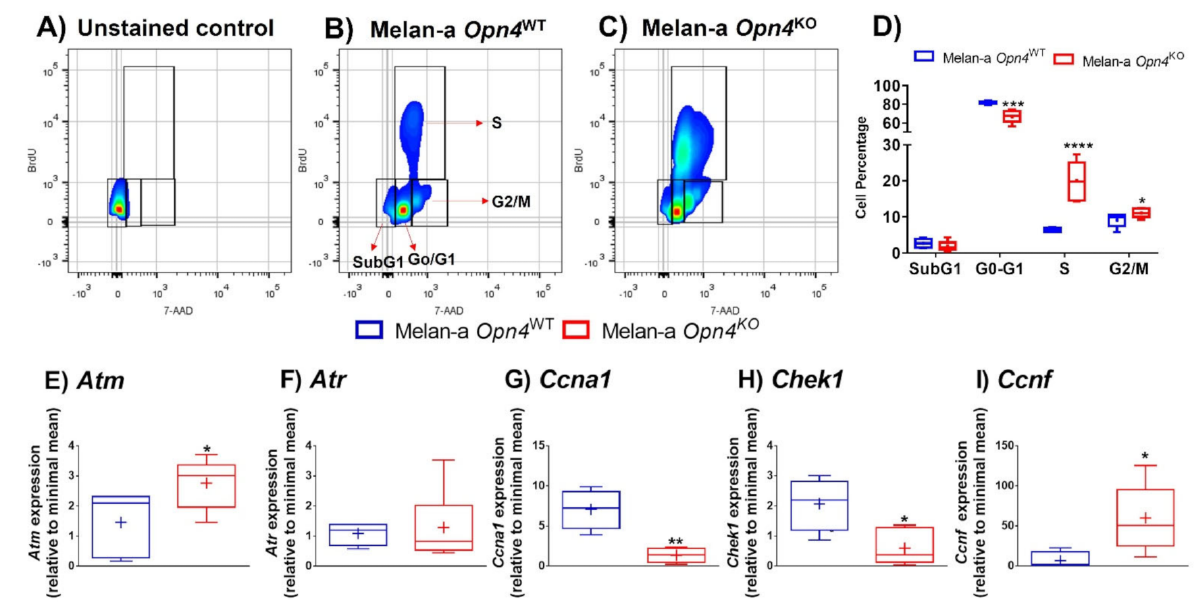
Figure 2. Cell cycle evaluation by 7-AAD and BrdU staining and by the expression of cell cycle-related genes in Opn4 WT and Opn4 KO melanocytes. ( A – C ) Representative gate of 7-AAD and BrdU stained cells; ( D ) quantitative analysis of cell cycle phases ( n = 5–6); ( E – I ) gene expression ( n = 4–8). * p < 0.05; ** p < 0.01; *** p < 0.001; **** p <